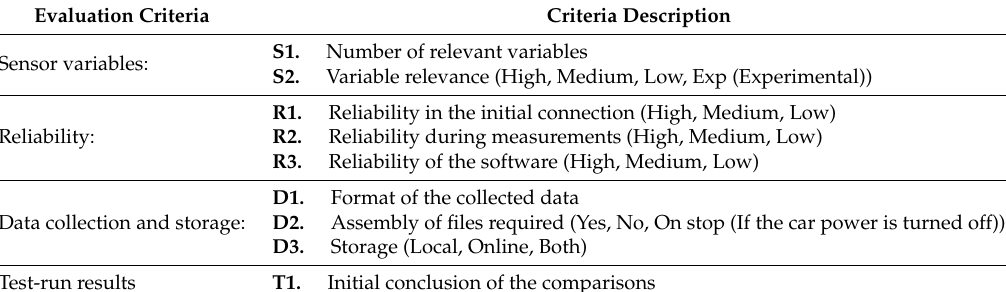
Table 1. Description of the evaluation